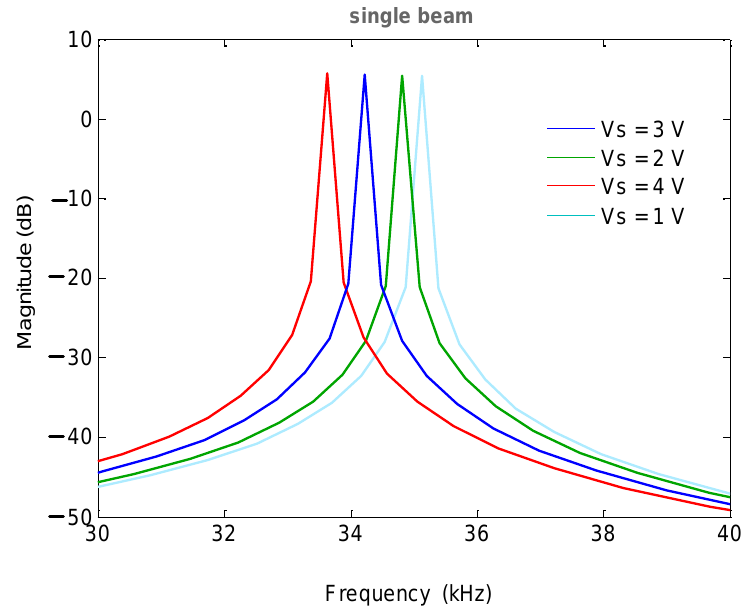
Figure 26. Numerical simulation model of the accelerometer.